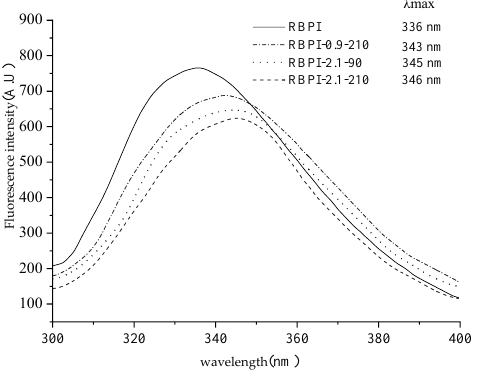
Figure 6. Intrinsic fluorescence spectra of RBPI prepared from different SFE pretreatment condi- tions.